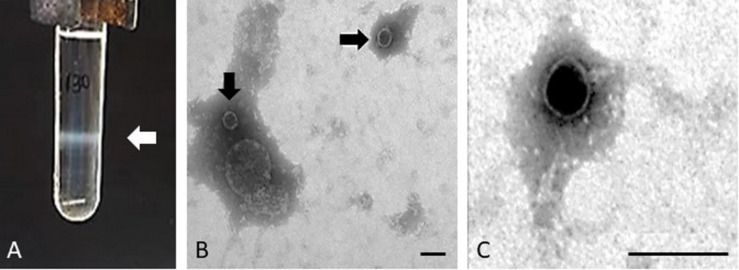
Phage purification. Example of the band comprising the Stx2 phage of isolate 62 and corresponding to a density of 1.5 g/ml in gradient of CsCl (A) and electron micrographs of Stx phage Φ62 (B,C). Bar 100 nm.